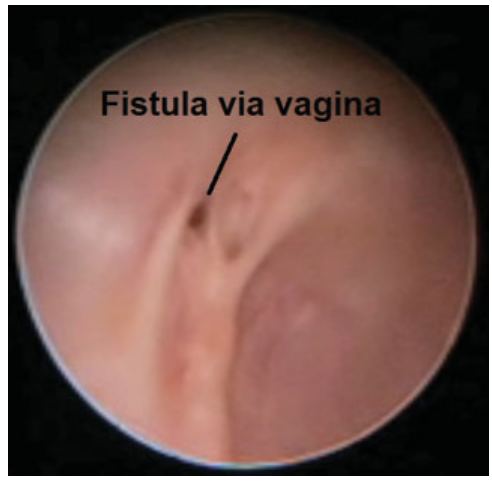
Fig. 4 The uretherovaginal fi stula via